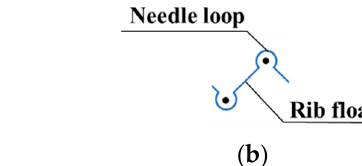
Figure 2. Geometrical model of the loop head by Č iukas (here d —yarn diameter; A —wale spacing; a – large radius of ellipse; b – small radius of ellipse), (mm).